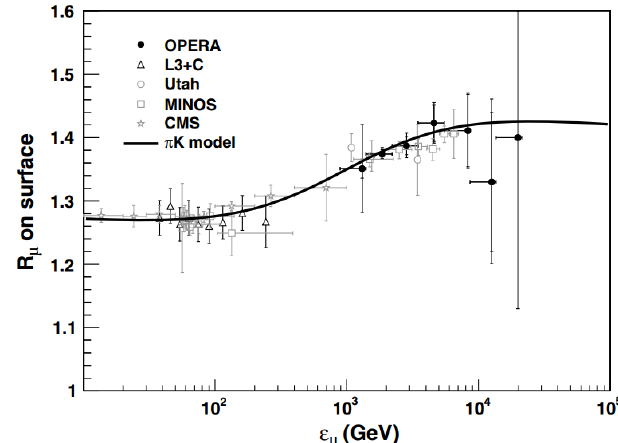
Figure 7. Muon charge ratio measured by OPERA and by other experiments as a function of the vertical surface energy (cid:101) µ